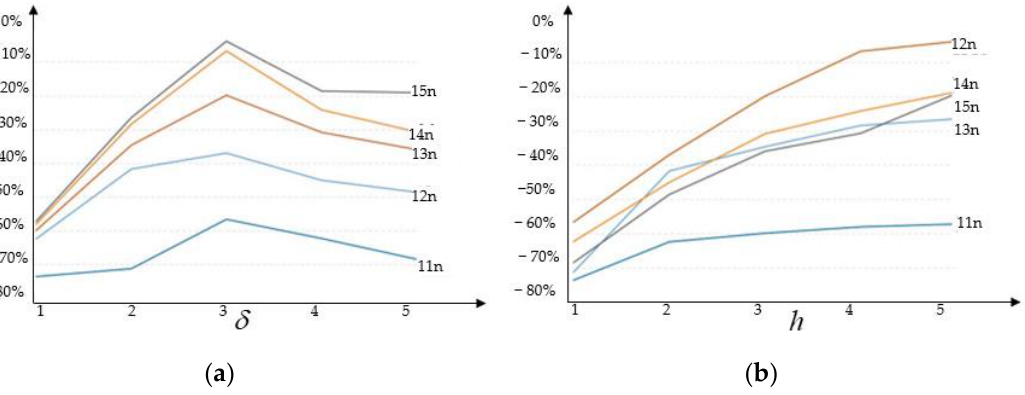
Figure 11. Mesh sensitivity under different horizons and grid sizes. ( a ) Percent error vs. horizon size ( δ convergence). ( b ) Percent error vs. particle spacing ( δ h convergence)